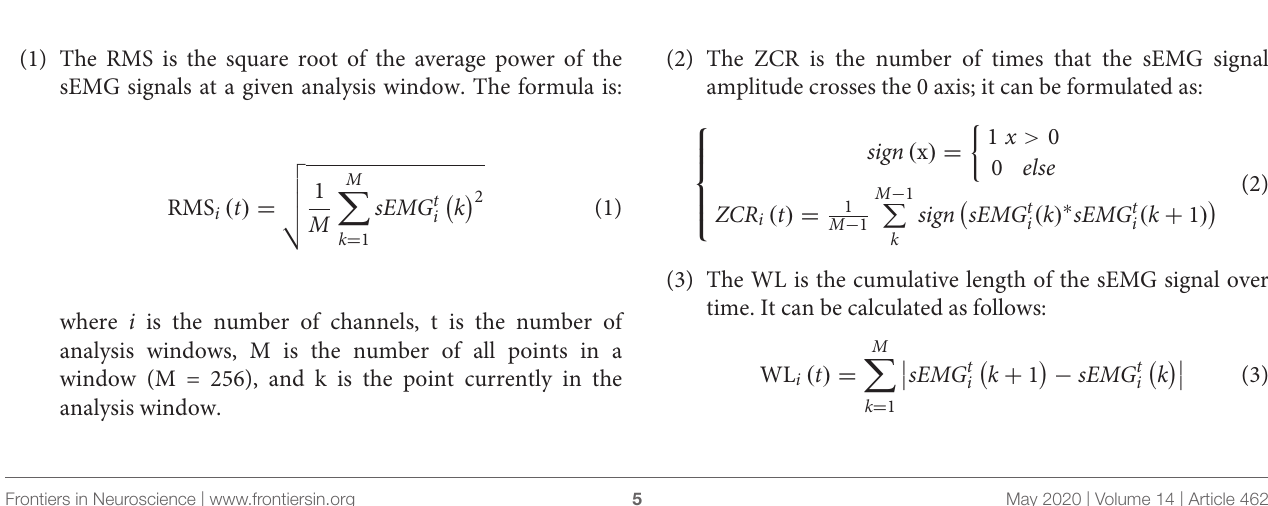
FIGURE 4 | The sEMG of biceps brachialis and the corresponding elbow joint angle during a single passive stretching process. The blue dashed line shows the onset of sEMG evoked by passive stretch, and the red dashed line shows the maximal elbow joint angle. The onset angle was used for feature extraction of healthy